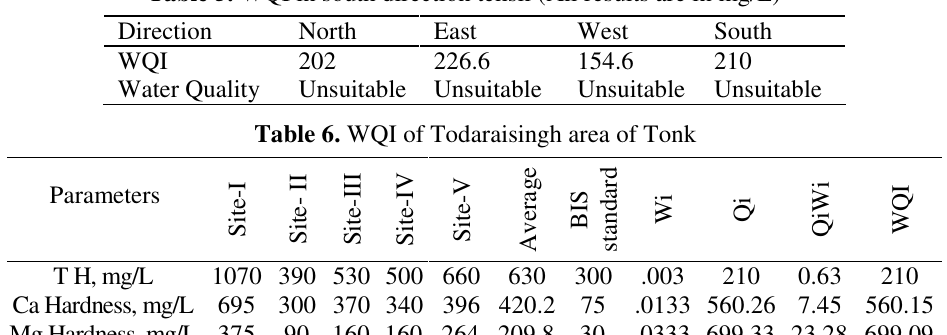
Table 5. WQI in south direction tehsil (All results are in mg/L)